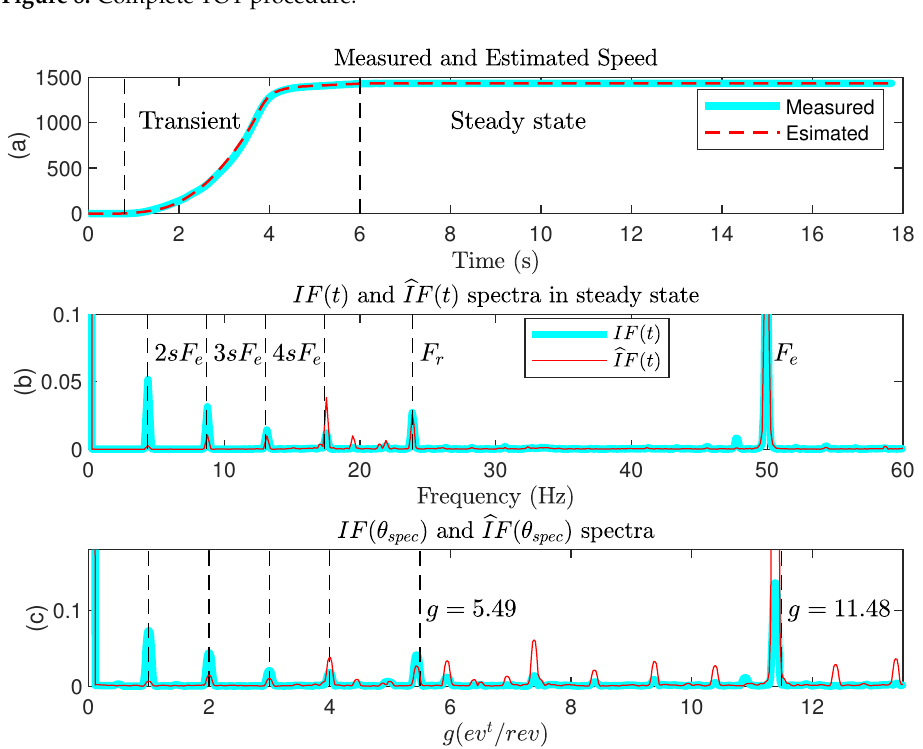
Figure 9. IF ( t ) and (cid:98) IF ( t ) analysis in steady